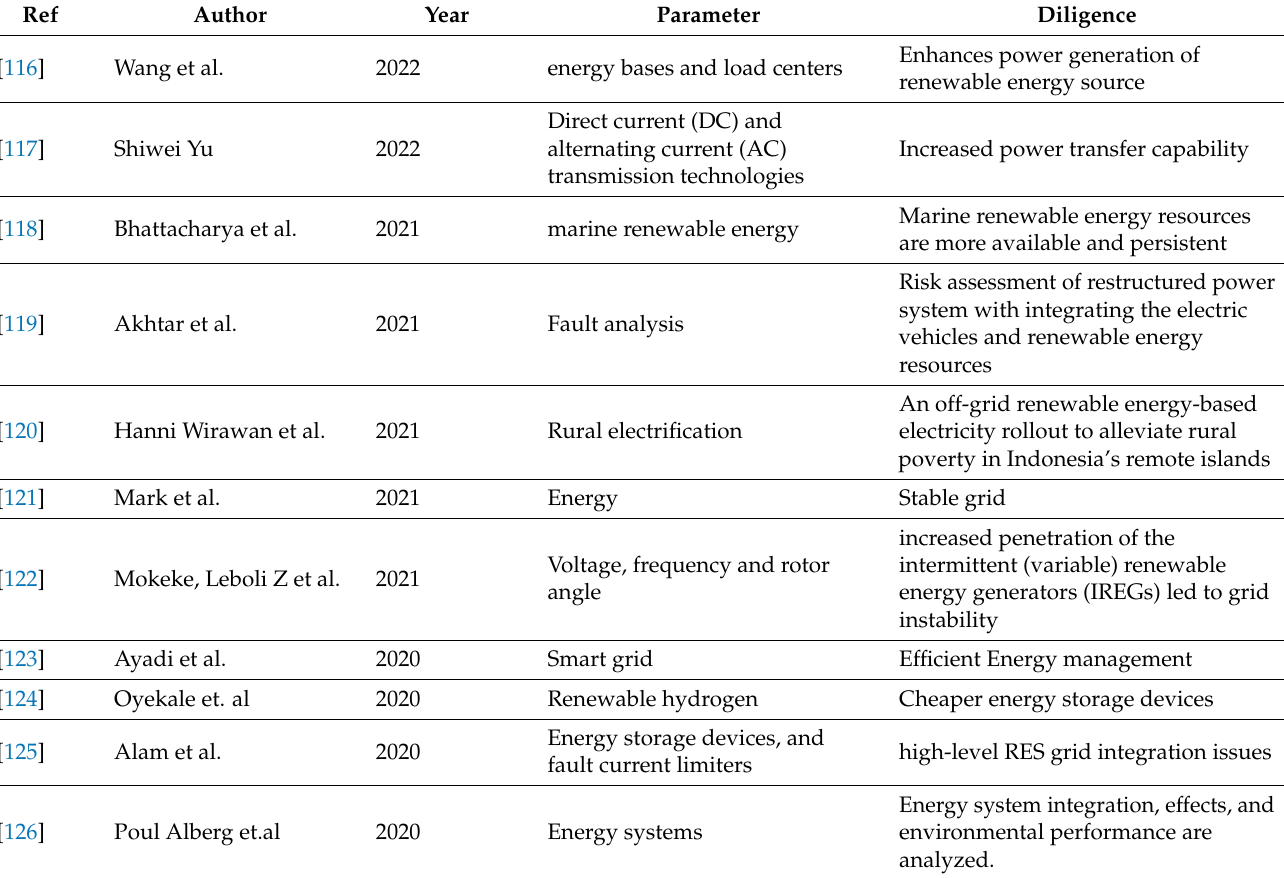
Table 4. Research work on impact of RES on power